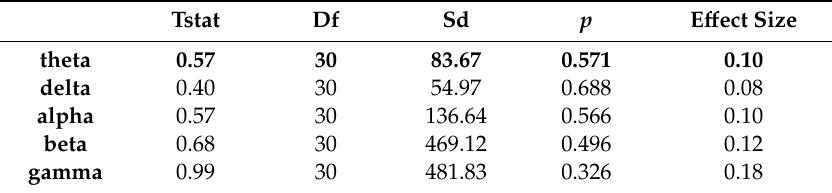
Table 5. t -test table for the occipital region (all bands) of the HERA model.